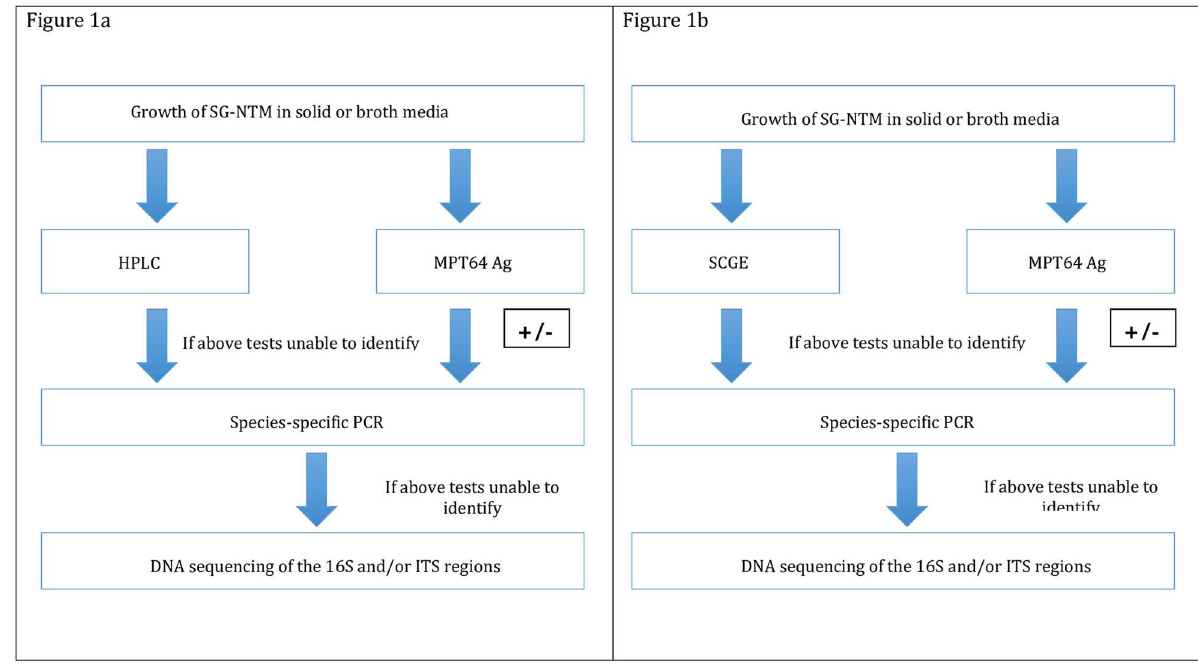
Fig 1. a. Algorithm used for identification of slowly growing nontuberculous mycobacteriain our laboratory. b. Proposed new algorithm incorporatingSCGE for identification of slowly growing nontuberculous mycobacteria. Species-specific PCR; “TB/MAC” PCR, targeting M. tuberculosis [IS6110] and MAC [ITS]; “KGSA 1” PCR, targeting M. gordonae [ITS] and M. kansasii [16S]; “KGSA2” PCR, targeting M. marinum/M.ulcerans [ITS], M. asiaticum [ITS] and M. szulgai [ITS].